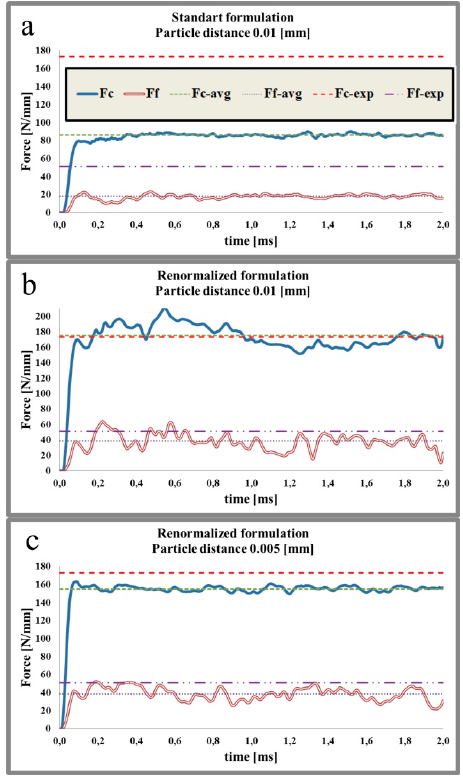
Figure 9. Cutting force F c and feed force F f versus time for h c = 0.1 mm.